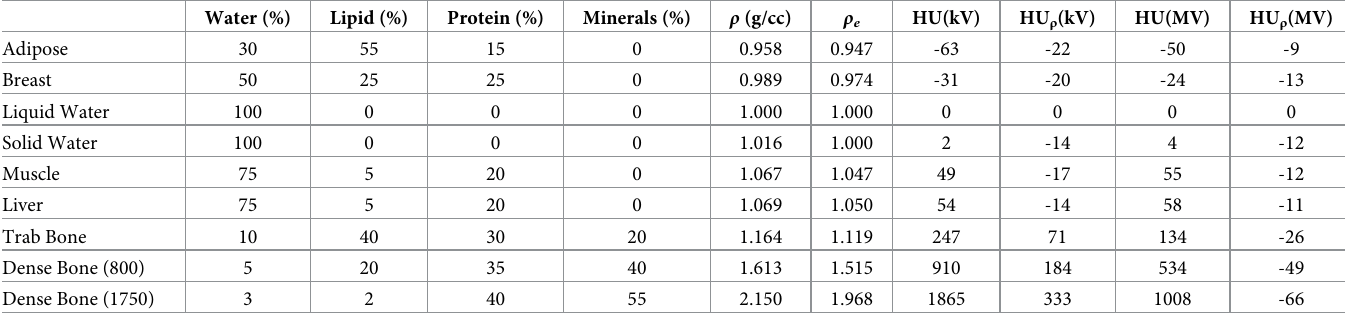
HU(kV) and HU(MV) were determined by kVCT and MVCT imaging of this phantom with HU ρ (kV) and HU ρ (MV) calculated by Eq